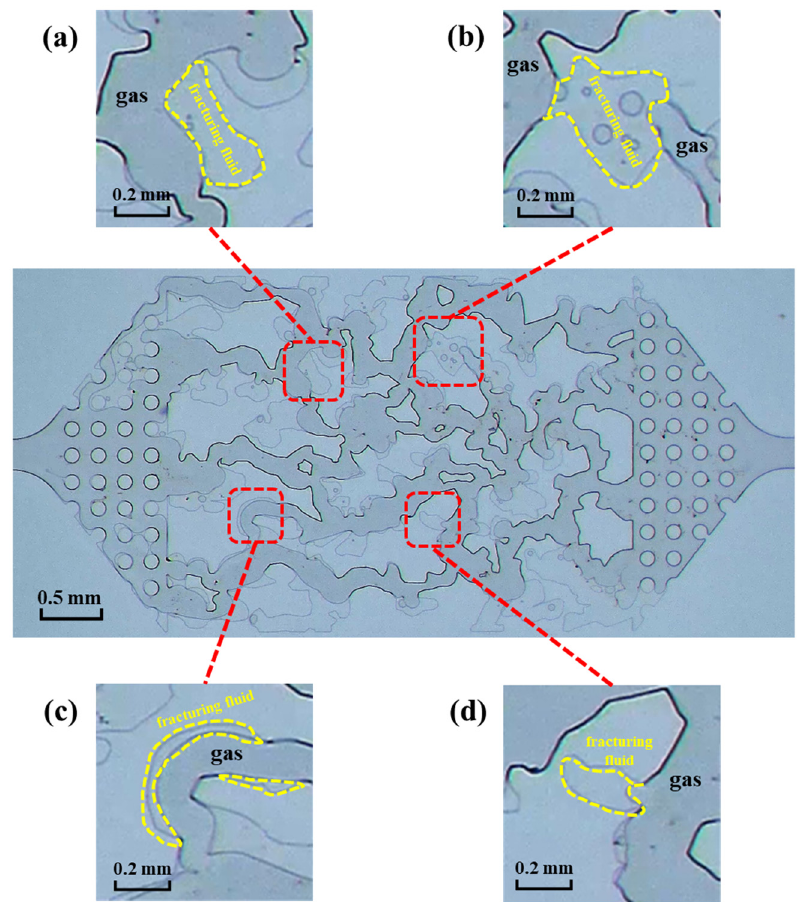
Figure 12. Four kinds of fracturing fluid retention in the microscopic model, fracturing fluid is in the light area, nitrogen is in the dark area and the residual fracturing fluid is marked by the yellow dashed box. ( a ) the viscous retention, ( b ) the Jamin effect, ( c ) the gas blockage effect, ( d ) the dead end of the pore.